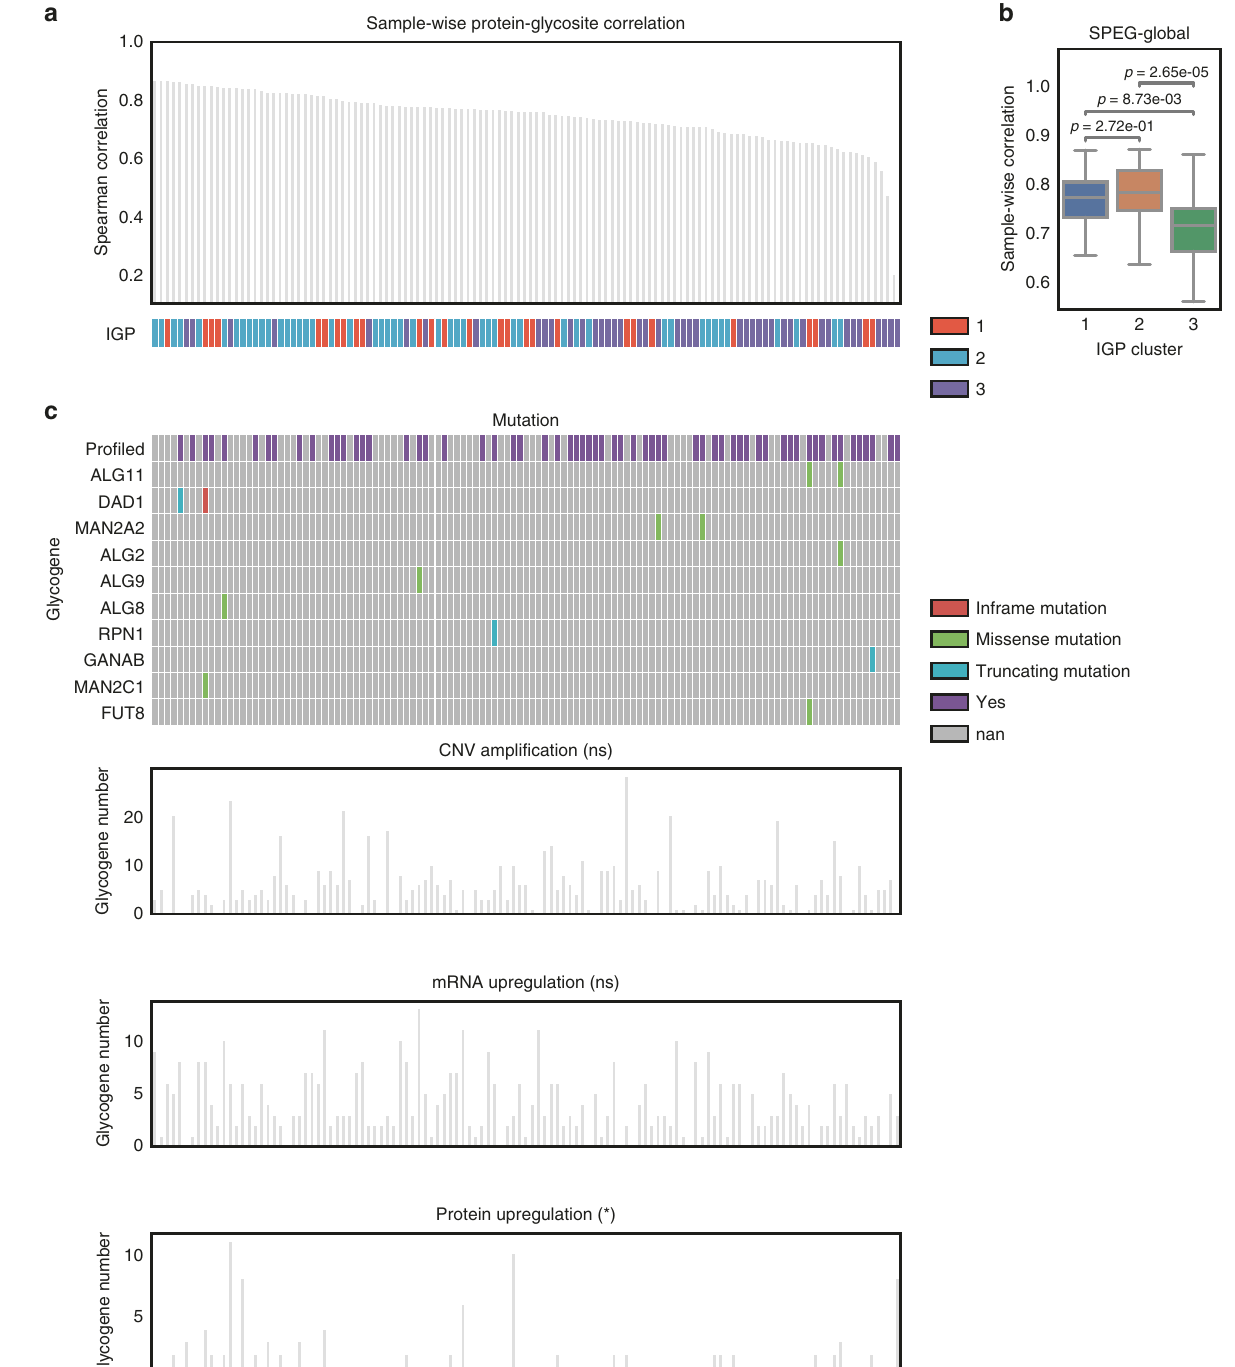
Fig. 4 Sample-wise correlation analysis between glycosites and proteins. a Barplot of sample-wise correlation between glycosite-containing peptides and global proteins of 119 HGSCs. IGP clusters are shown in bottom panel. b Boxplot of sample-wise correlations in 3 IGP clusters. In IGP cluster 1, n = 27 samples; in IGP cluster 2, n = 49 samples; in IGP cluster 3, n = 43 samples. p = 0.272 (IGP cluster 1 vs. IGP cluster 2), p = 8.73e − 3 (IGP cluster 1 vs. IGP cluster 3), and p = 2.65e − 5 (IGP cluster 2 vs. IGP cluster 3) two-tailed unpaired Student ’ s t -test. The box outlines denote the IQR, the solid line in the box denotes median correlation value, and the whiskers outside of the box extend to the minimum and maximum correlation values. c Glyco-related gene variations at mutation, copy number ampli fi cation, mRNA, and protein levels. The number of up-regulated glyco-related gene are compared between top 50 samples with higher correlations and 50 samples with lower correlations using two-tailed unpaired Student ’ s t -test without adjustment. NS indicates non-signi fi cance, * indicates signi fi cance. Only protein level shows a signi fi cant difference ( p = 0.03). Source data are provided as a Source data fi